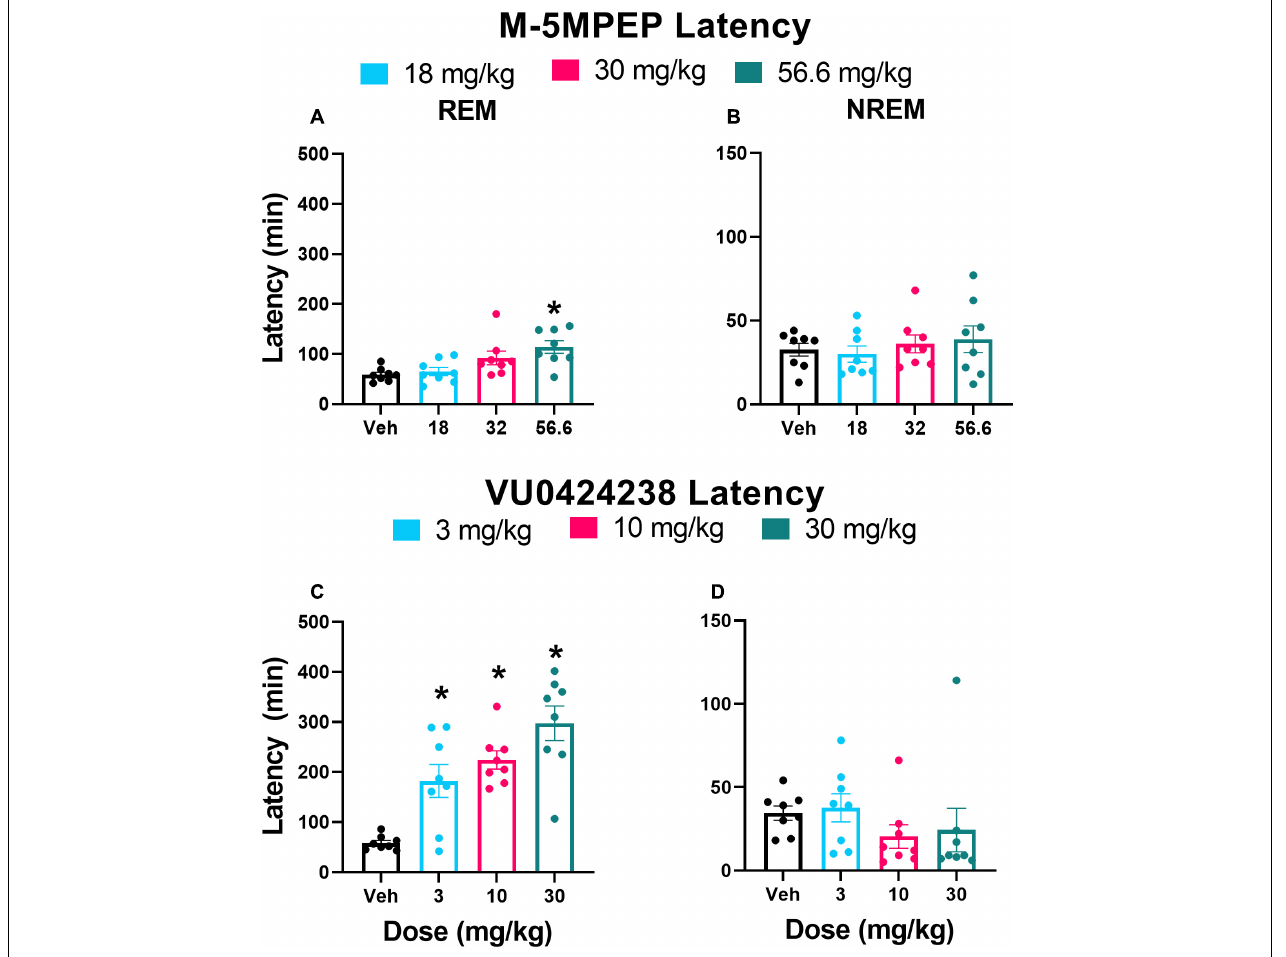
FIGURE 3 | M-5MPEP and VU0424238 both increase latency to REM sleep. Latency to REM (A,C) , and NREM (C,D) sleep were assessed following administration of either M-5MPEP (A,B) or VU0424238 (C,D) . * p < 0.05 compared to respective vehicle-treated condition. Bars show mean ± SEM ( n = 8); circles depict individual data